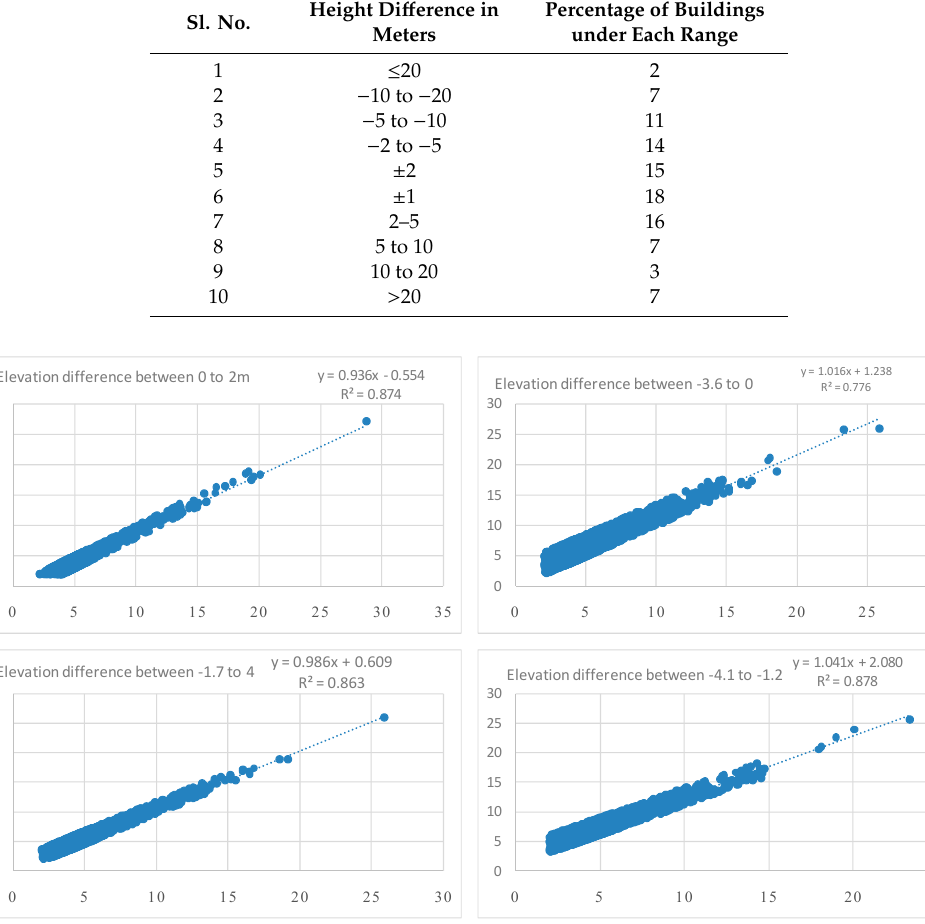
Figure A2. Scatter plot showing correlation between AW3D-30 DSM- and LiDAR DSM-generated heights for different ranges.